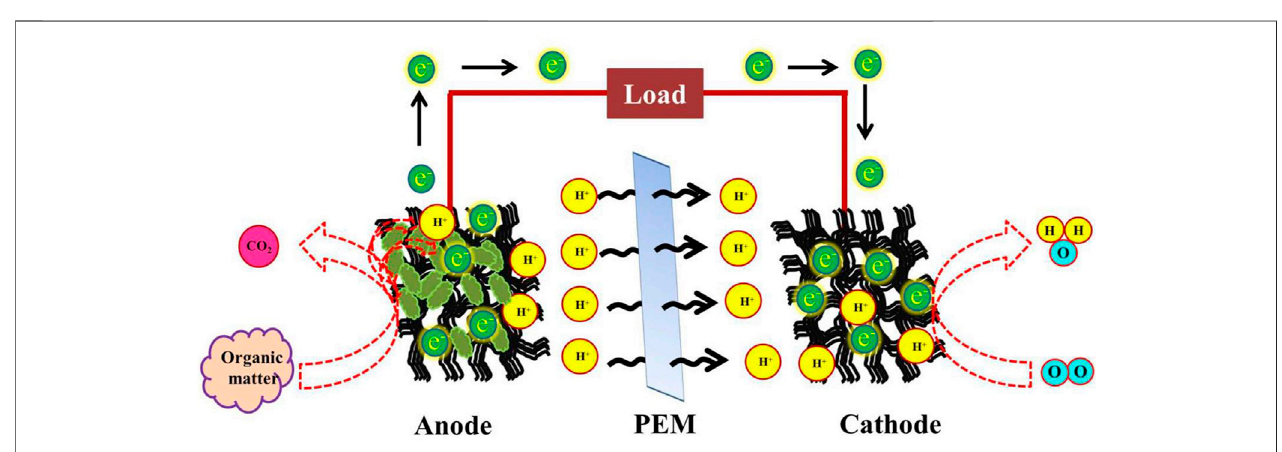
FIGURE 5 | Using photosynthetic microorganisms at the anode, an MFC can reduce waste while also producing power (Angelaalincy et al., 2018).